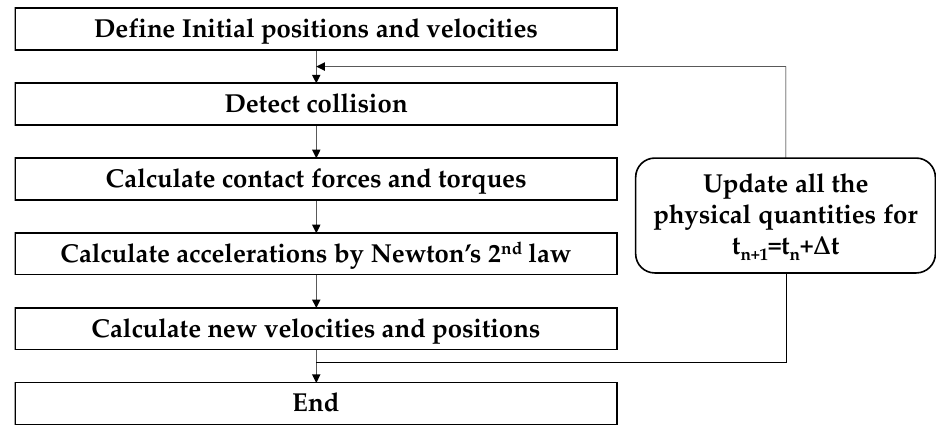
Figure 3. General procedure of discrete-element (DEM) analysis based on explicit structural dynamic analysis.